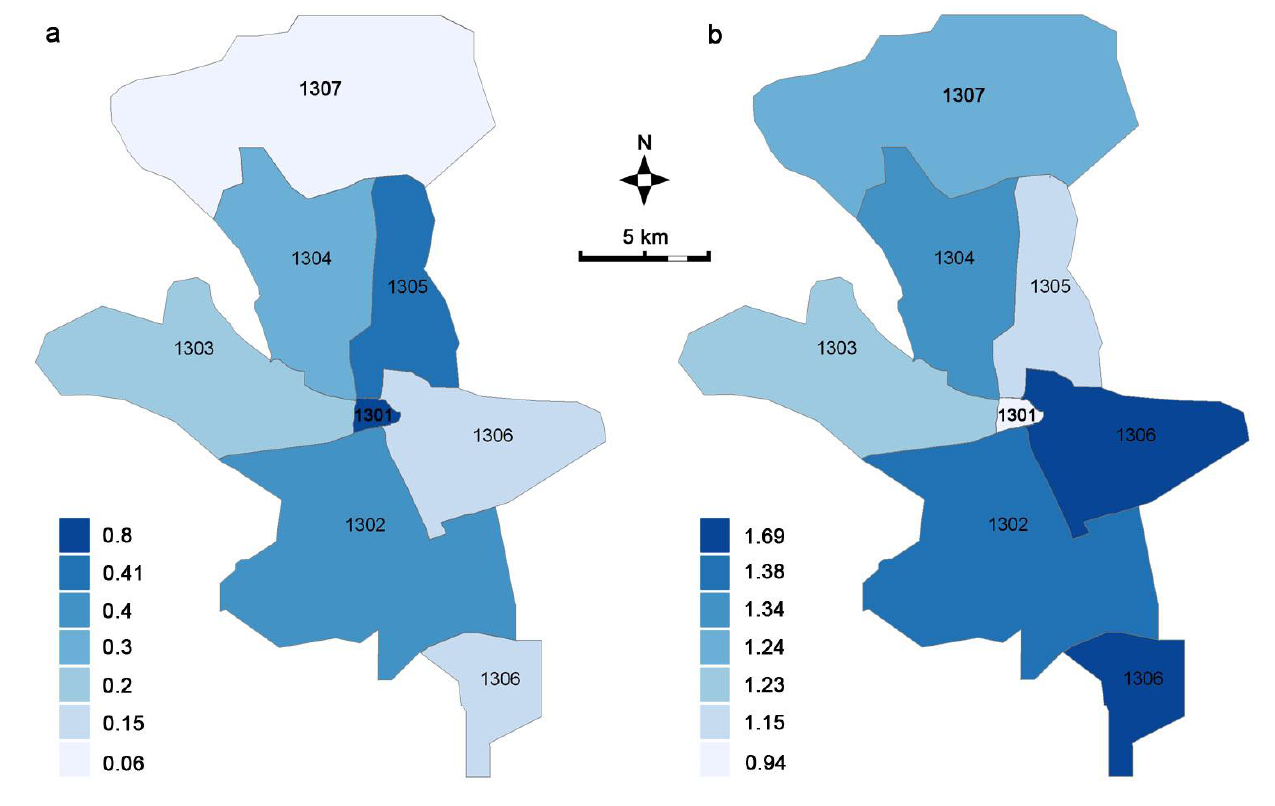
Figure 7. Urban density [km 2 /district] in 2007, ( a ) changes in urban density by district between 1994 and 2007, ( b ) displayed as a